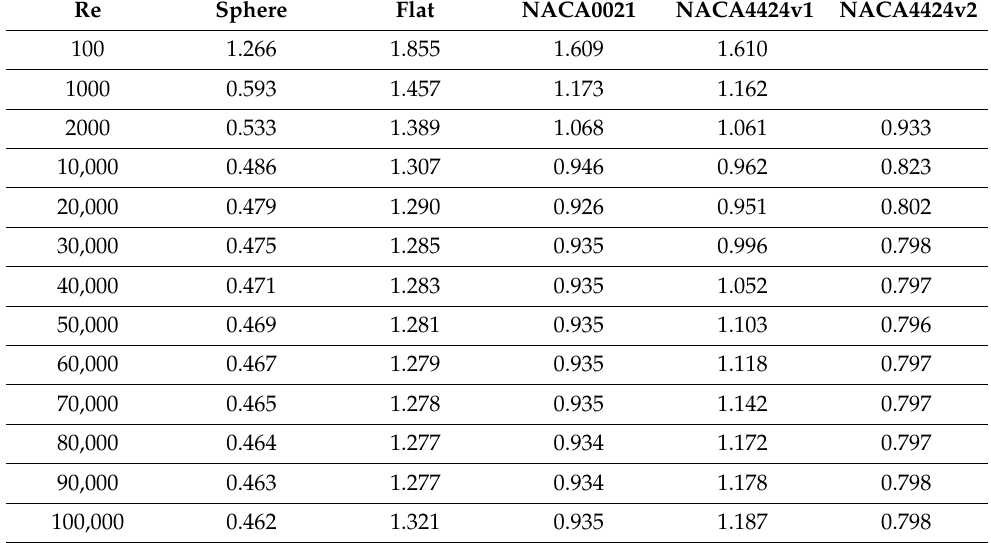
Table 3. Calculated drag coefficients.